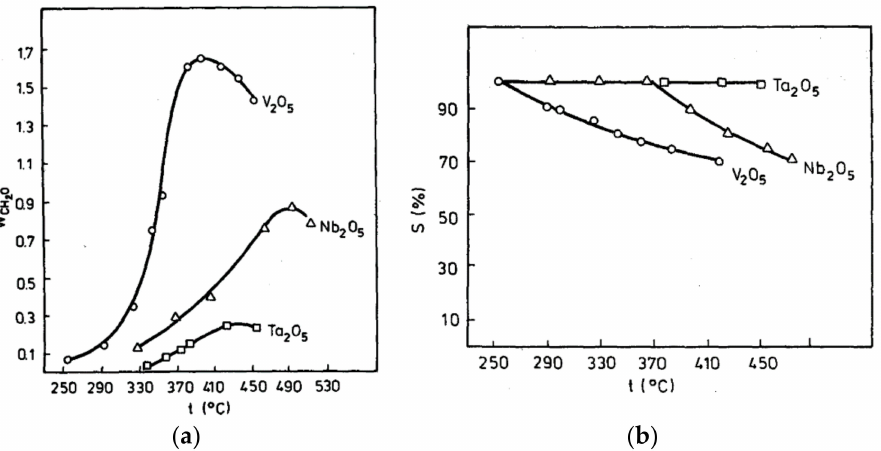
Figure 47. Dependence of activity ( a ) and selectivity ( b ) in MeOH oxidation of the group 5 metal oxides on temperature. Reprinted by permission from [166] Springer nature, Reaction Kinetics and Catalysis Letters, Copyright